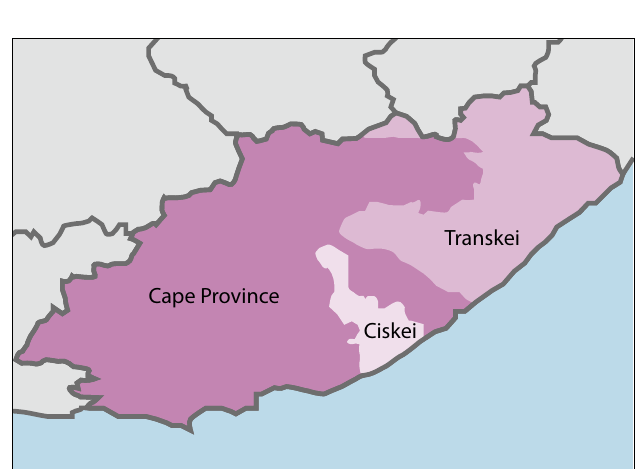
Fig. 1. Boundaries of the Cape Colony.